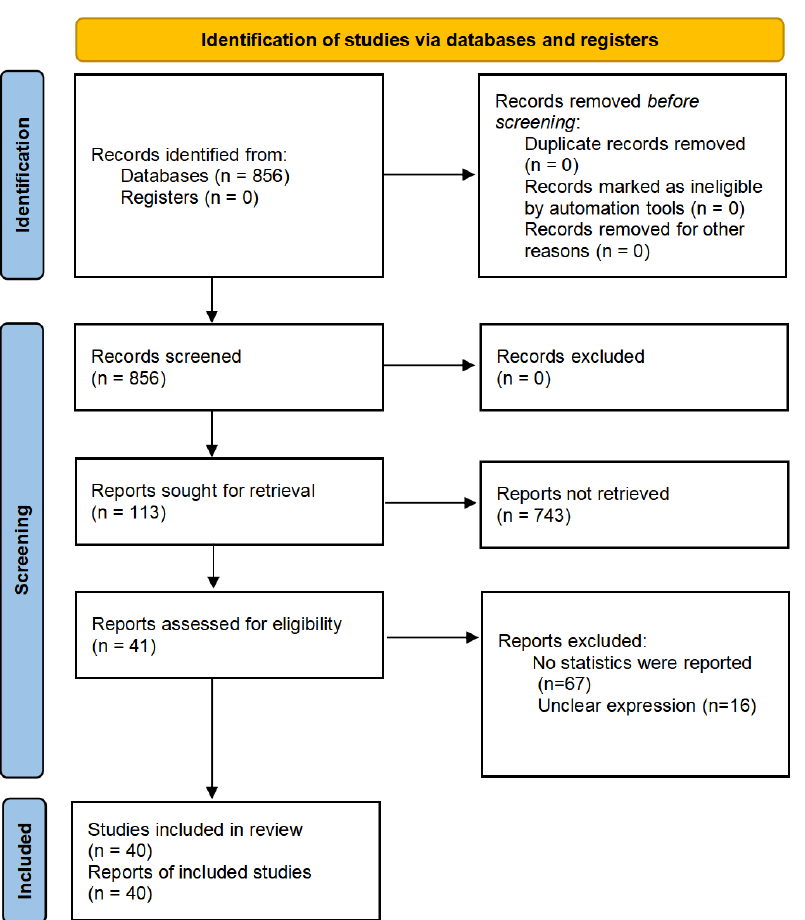
Figure 1. Flow chart of the study selection process in the 2020 PRISMA protocol. This flowchart coincides with the broad-certified 2020 PRISMA statement.